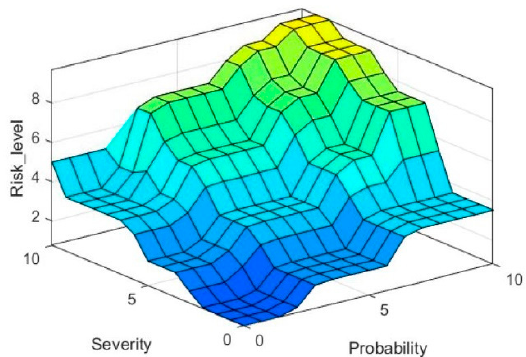
Figure 6. Fuzzy risk matrix combining the three variables for risk analysis.